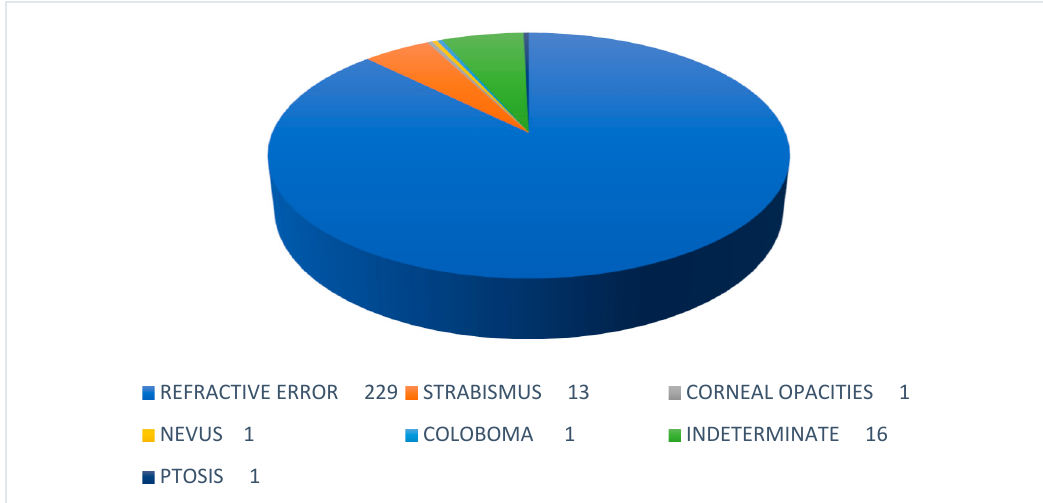
Figure 4. Pie diagram depicting the various ocular morbidities detected in screened population by the evaluator.